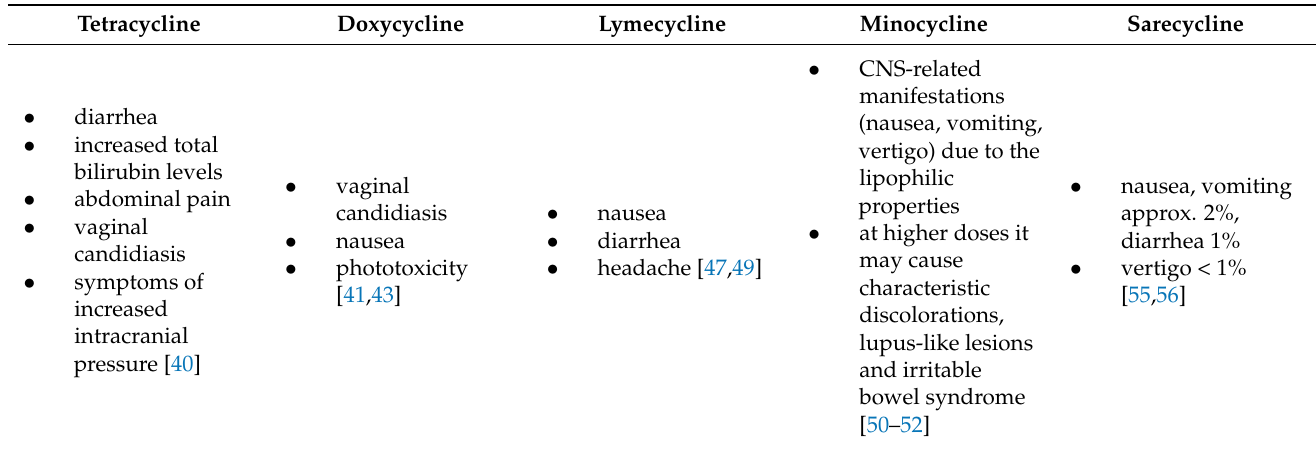
Table 2. The most common adverse effects of tetracycline